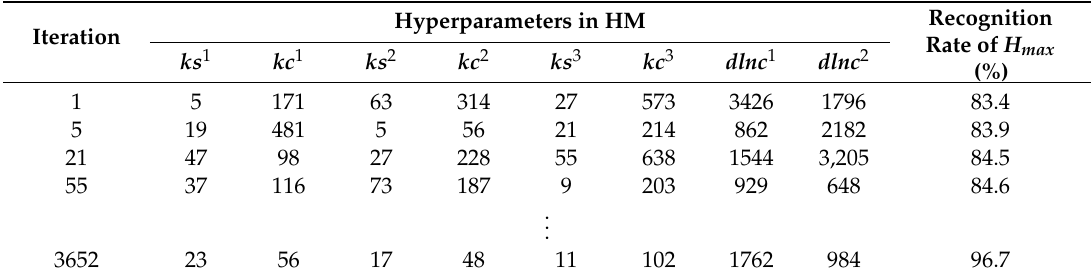
Table 8. Hyperparameter combination and recognition rate when H max was updated.